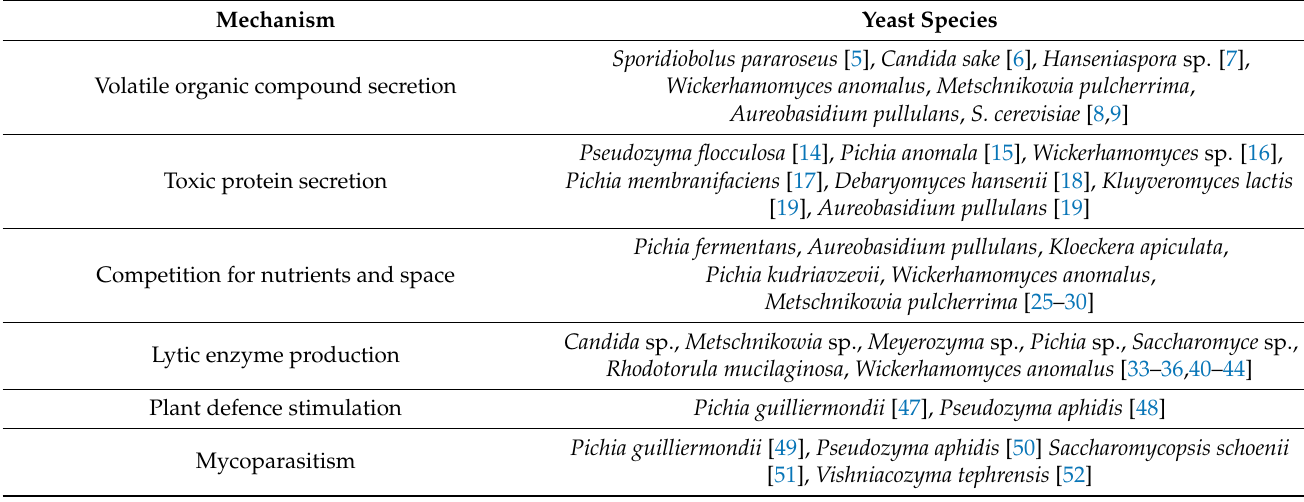
Table 1. Multiple mechanisms of yeast as biocontrol